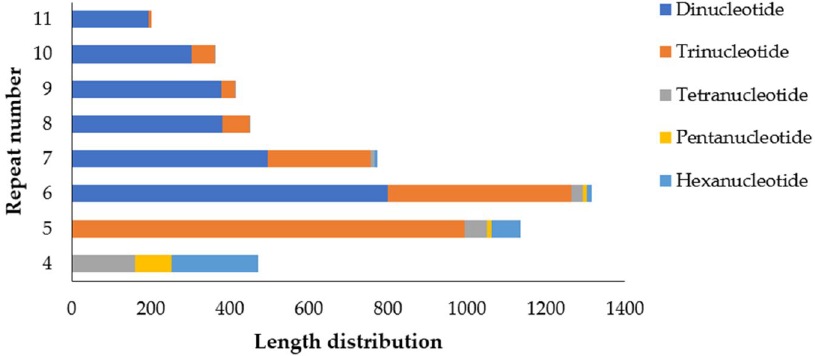
Figure 5. Length distribution of the EST-SSRs of S. incisa based on the number of nucleotides repeat units.